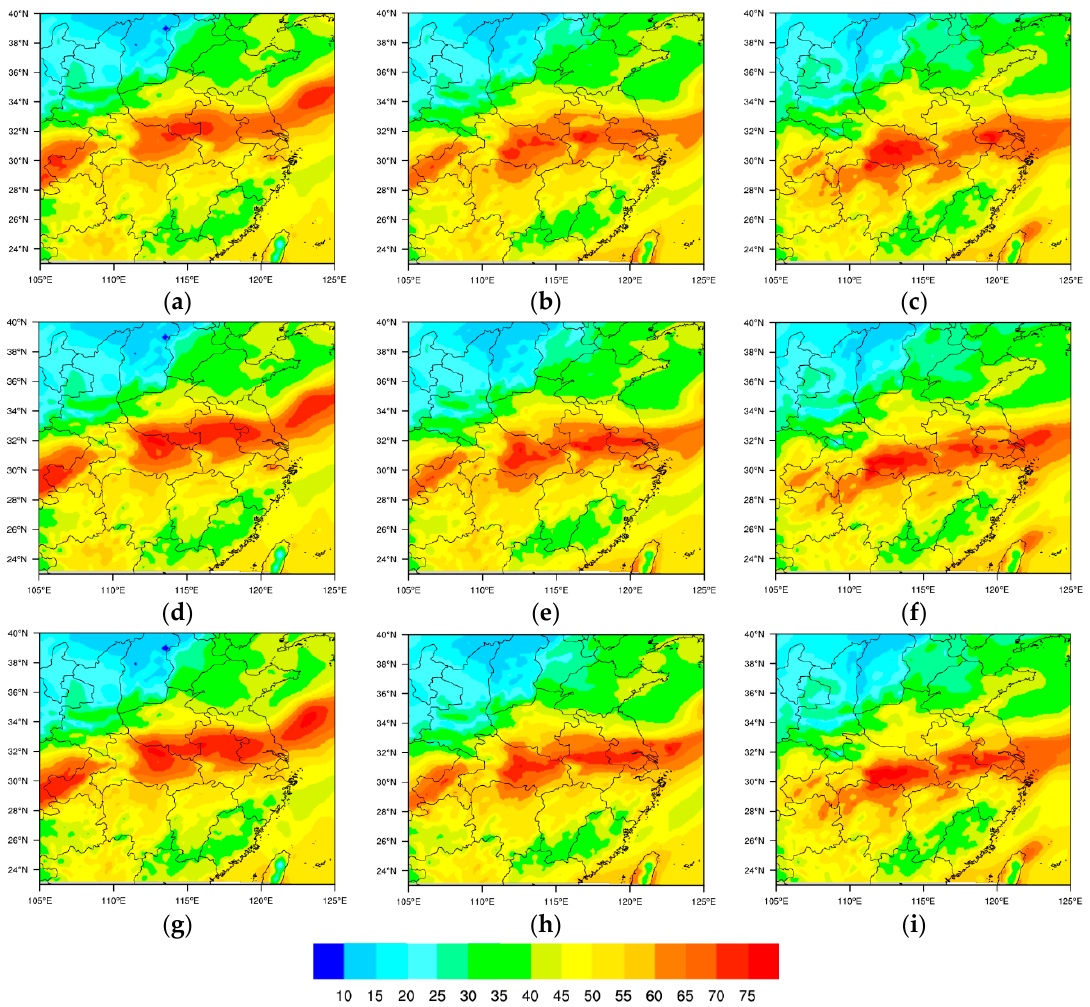
Figure 12. Precipitable water (mm) of analyses ( a , d , g ), 6 h forecasts ( b , e , h ) and 12 h forecasts ( c , f , i ) for conv4dvar ( a – c ), pcp4dvar ( d – f ), and convpcp4dvar ( g – i ) initialized at 0600 UTC 05 July 2013.